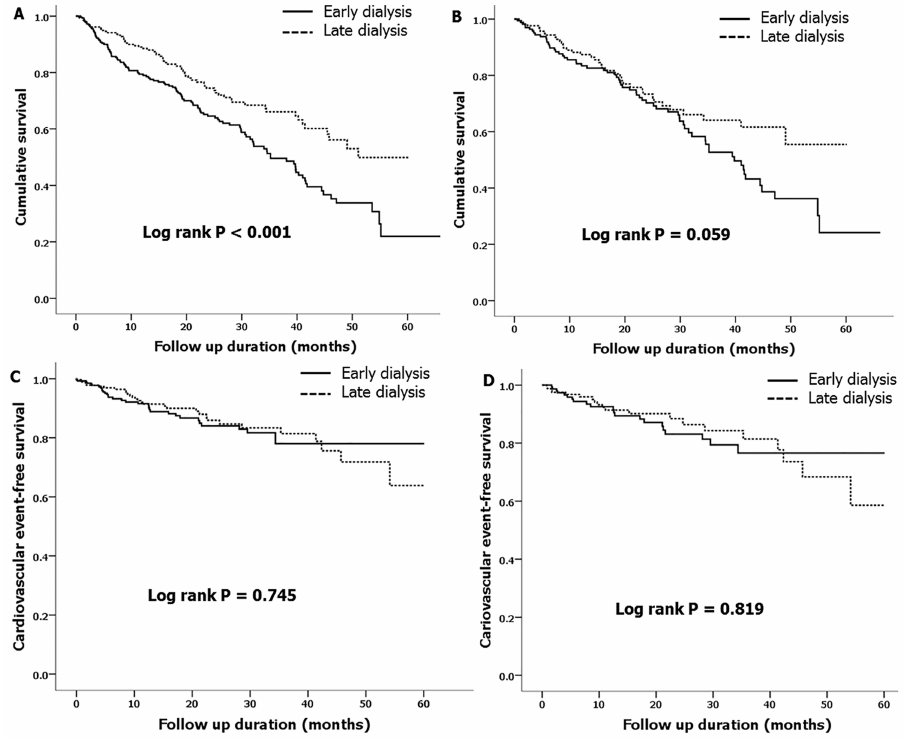
Fig 2. Cumulative patient survival (A and B) and cardiovascular event-free survival (C and D) obtained using the Kaplan-Meier method in the cohort differentiated by the median estimated glomerular filtration rate before (A and C) and after (B and D) propensity score matching.